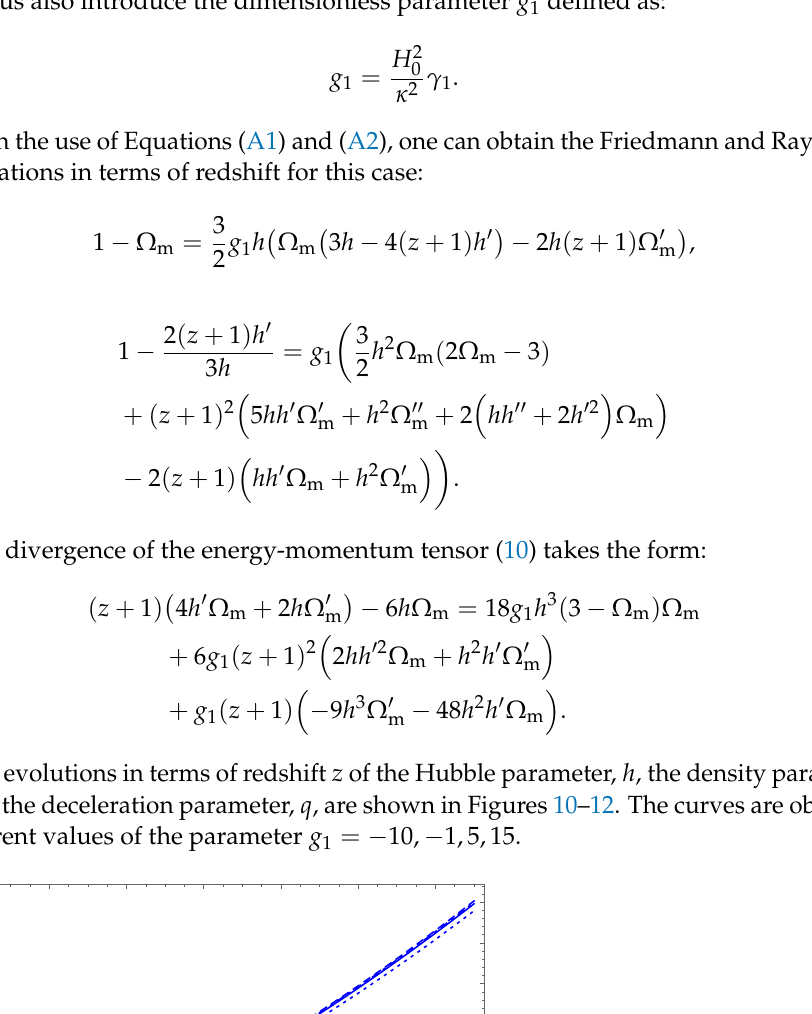
Figure 10. Variation of the Hubble function, h , as a function of z for K µν = − γ 1 different values of the parameter g 1 : g 1 = − 10 (solid curve), g 1 = − 1 (dotted curve), g 1 = 5 (dashed curve), and g 1 = 15 (dot-dashed curve). The evolution of the Hubble function in the standard Λ CDM model is represented by the red solid